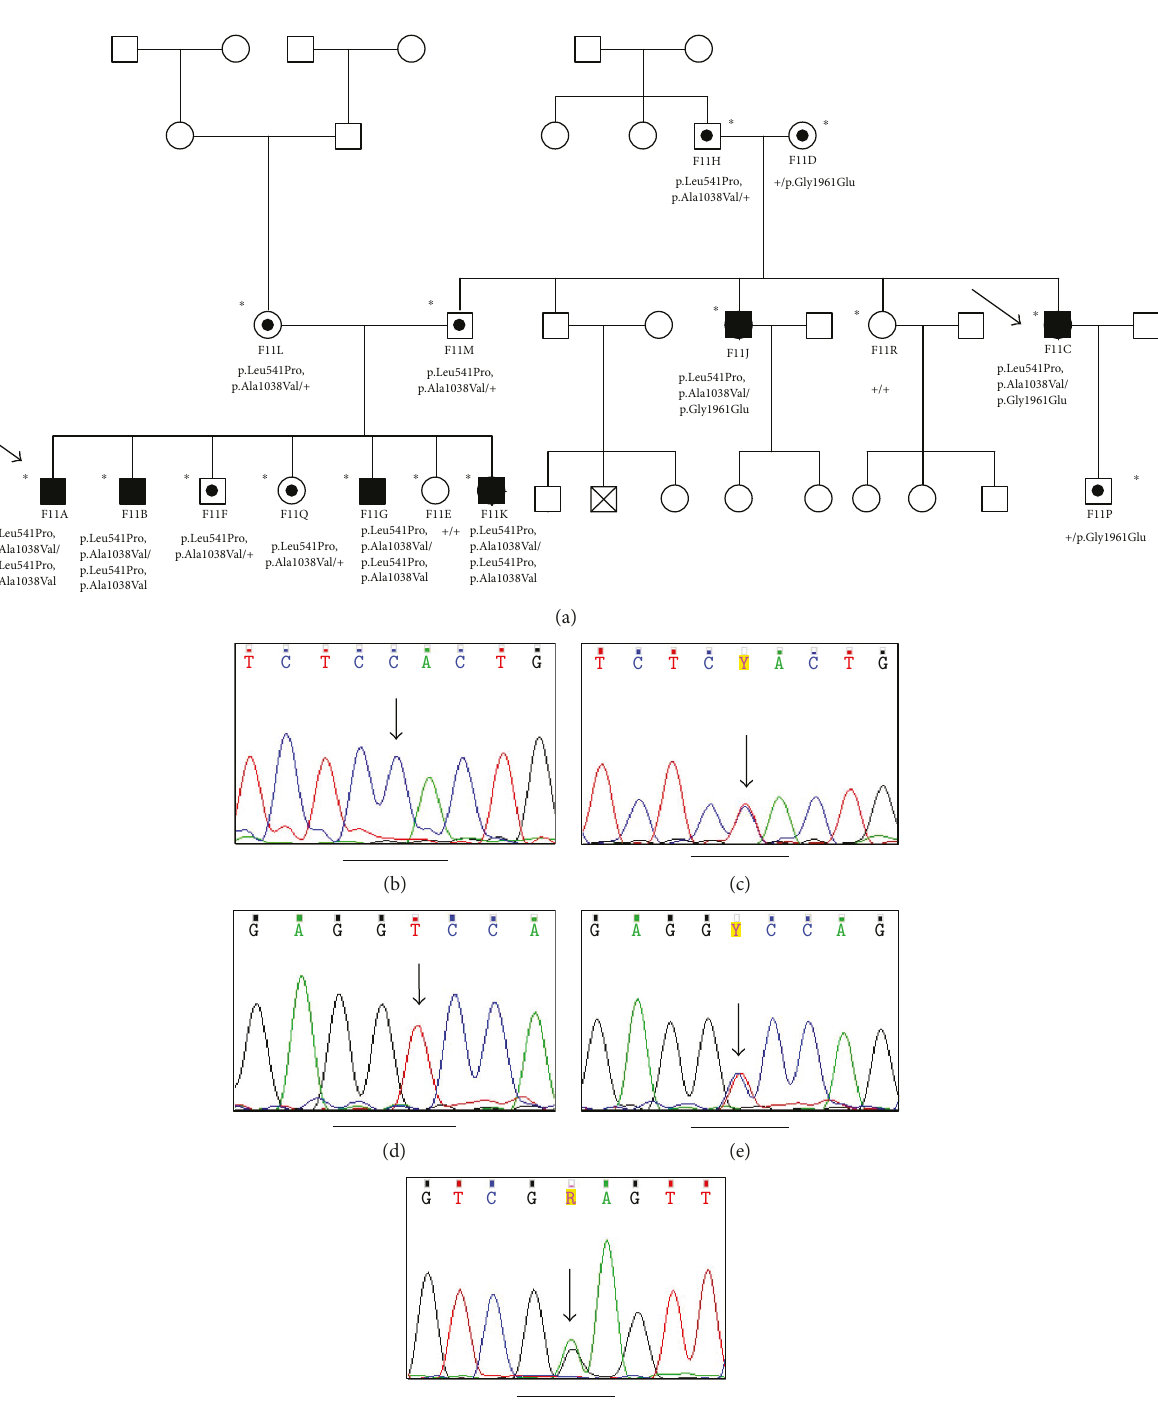
Figure 1: Family F11. (a) Pedigree of patients F11A and F11C (probands). Arrows indicate the probands. A ff ected and una ff ected individuals are represented with black and open circles, respectively. Males are represented with a quadrant and females with a circle. The asterisk denotes the individuals genetically examined. A dot in a symbol denotes an una ff ected carrier of the respective mutation. Pluses (+) denote the wild type alleles. (b, c, d, and e) Sequence chromatograms of the F11A and F11C showing the complex allele c.1622T > C/c.3113C > T (p.Leu541Pro/ p.Ala1038Val) in homozygosity in proband F11A (b, d) and in heterozygosity in proband F11C (c, e). (f) Sequence chromatogram of the proband F11C showing the missense mutation c.5882G > A (p.Gly1961Glu) in heterozygosity on the second allele. The arrow indicates the position of the G to A substitution at the second nucleotide of codon 1961 encoded by GGA marked by a horizontal